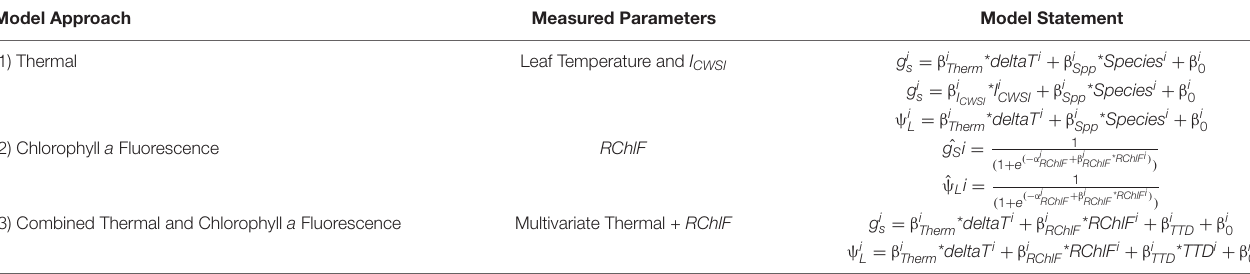
TABLE 1 | Three image-based modeling approaches [i.e., thermal, relative chlorophyll a fluorescence ( RChlF ), and combined thermal and RChlF )] for predicting plant water status parameters [i.e., stomatal conductance ( g s ) and leaf water potential ( (cid:57) L )] with respect to species and drought induced time to death (TDD). Model